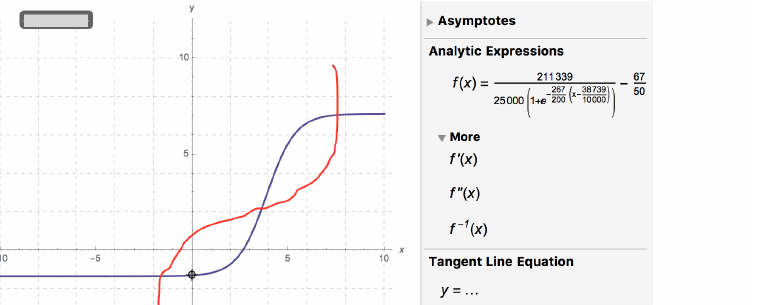
Figure 11. A student’s response to a question about invertibility, raised in a classroom learning environment (during the global pandemic caused by the coronavirus SARS-CoV-2).